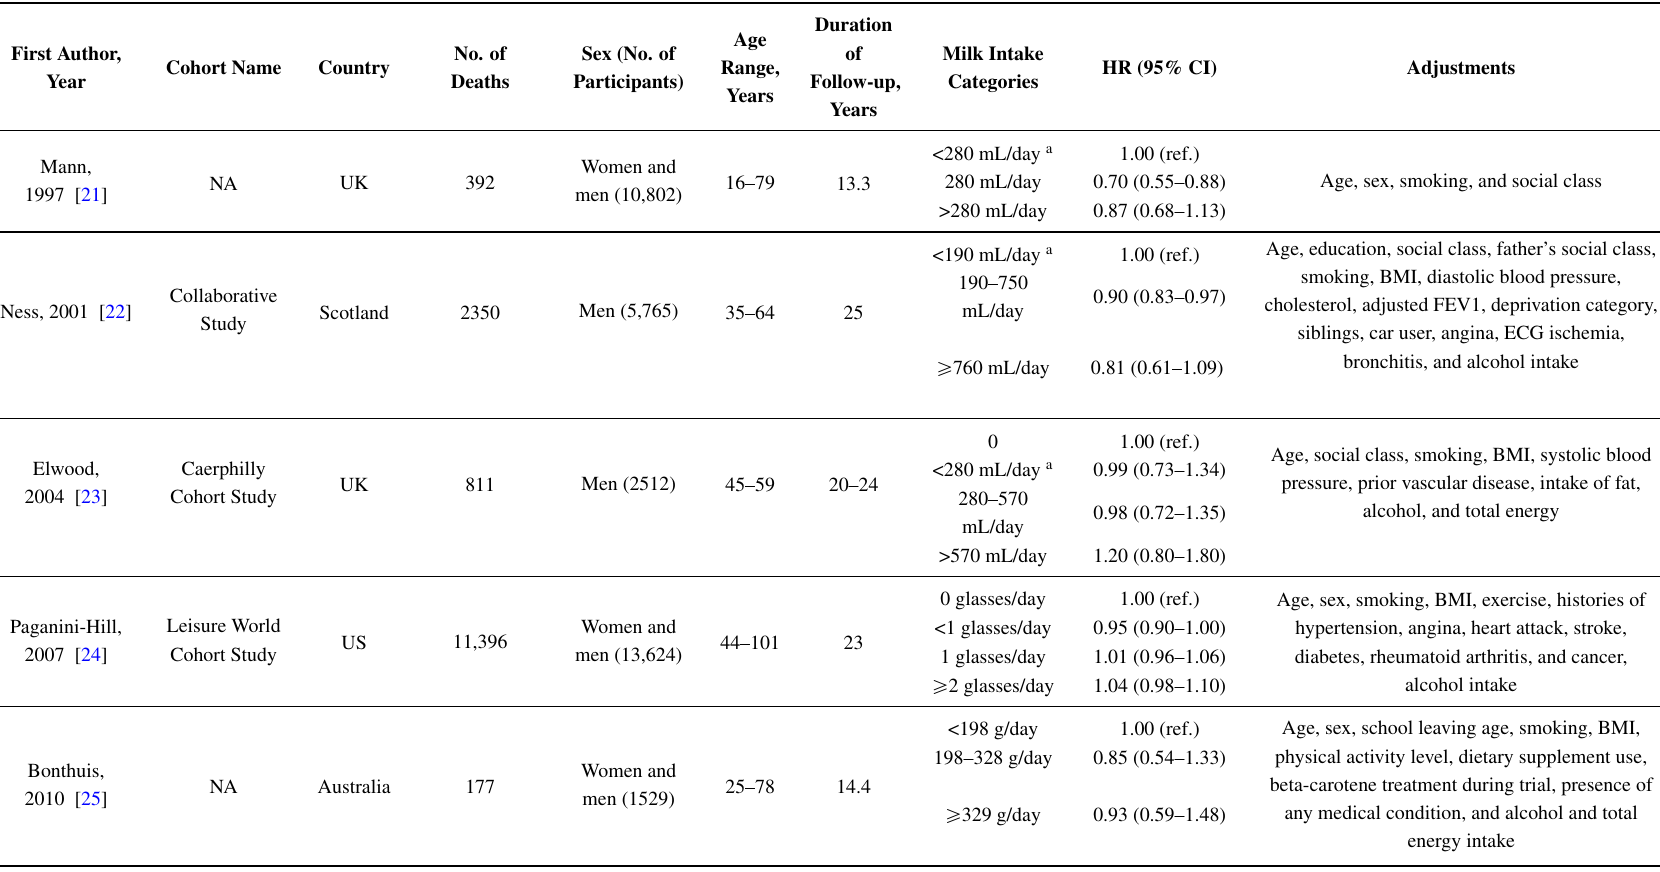
Table 1. Characteristics of studies included in meta-analysis of milk consumption and all-cause